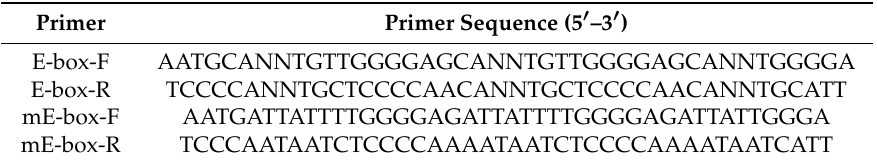
Table 2. The probe sequences contained the E-box core sequences or mutation